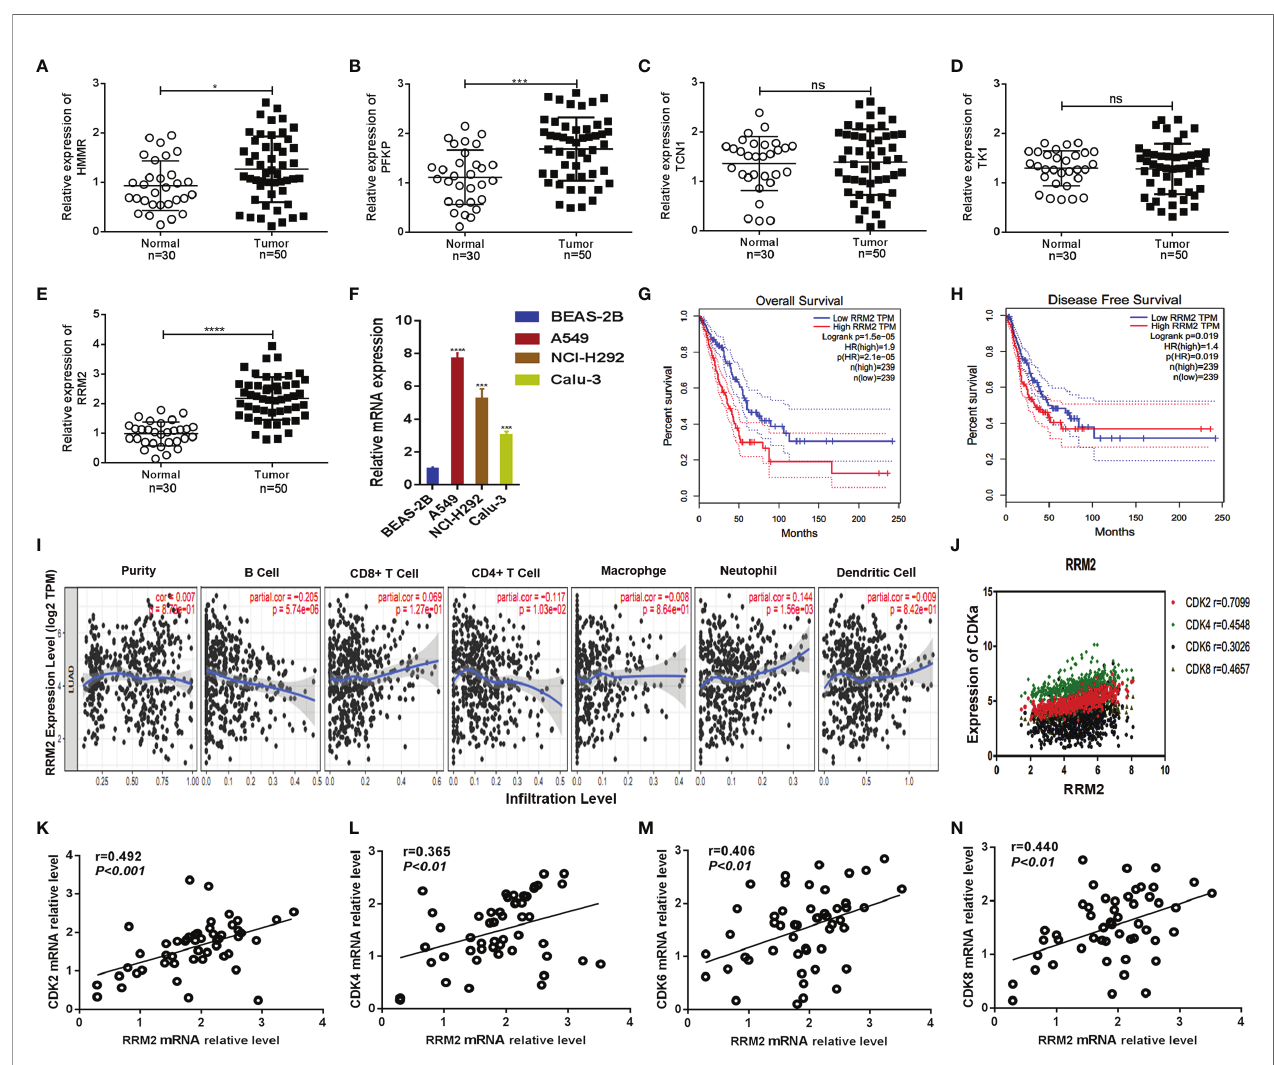
FIGURE 7 | RRM2 was related to survival time and CDK family. (A – E) Expression levels of HMMR, PFKP, TCN1, TK1 , and RRM2 in non-cancerous tissues (n = 30) and LUAD tissues (n=50) were detected by qRT-PCR. GAPDH was used as an internal control; (F) RRM2 expression levels in different cell lines were determined by qRT-PCR. GAPDH was used as an internal control; (G, H) Kaplan – Meier analysis was performed to assess the association of RRM2 expression with overall survival and disease-free survival in LUAD patients using the TCGA databases; (I) Correlation of RRM2 with immune cell in fi ltration in lung cancer; (J – N) Association of RRM2 with the CDK2 family of proteins. *, P < 0.05. **, P < 0.01. ***, P < 0.001. ****, P < 0.0001. ns : Not Statistically Signi fi